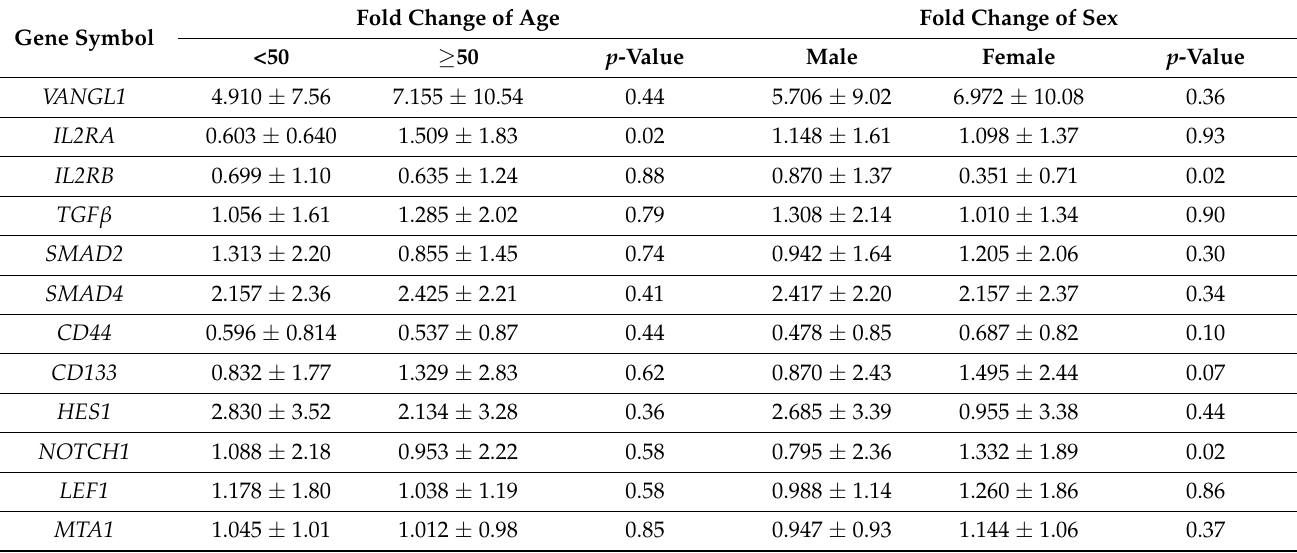
Table 3. Relationships between the expression of 20 CRC study genes and age and